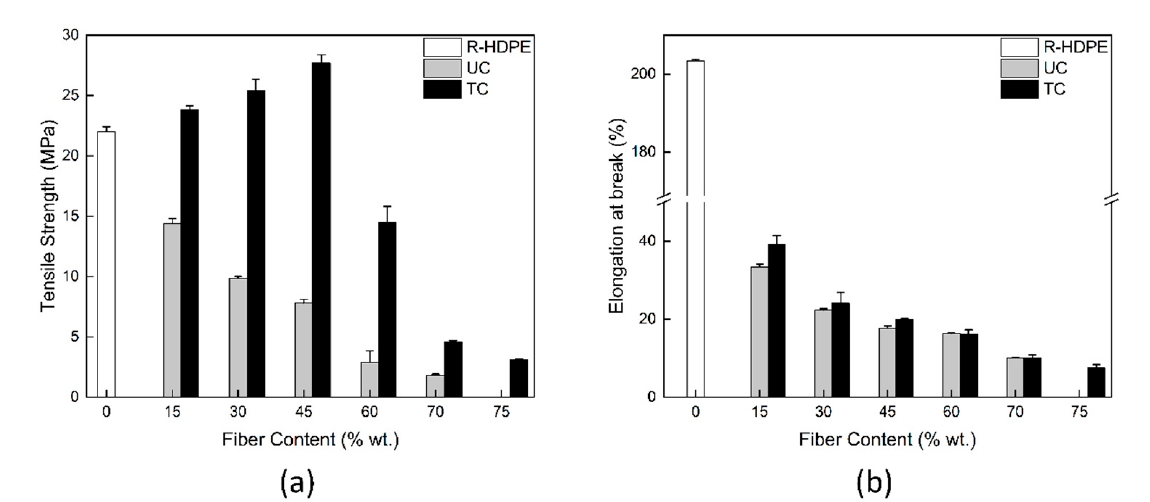
Figure 12. Tensile strength ( a ) and elongation at break ( b ) of the recycled high-density polyethylene (R-HDPE), untreated (UC) and treated (TC) composites as a function of fiber content.